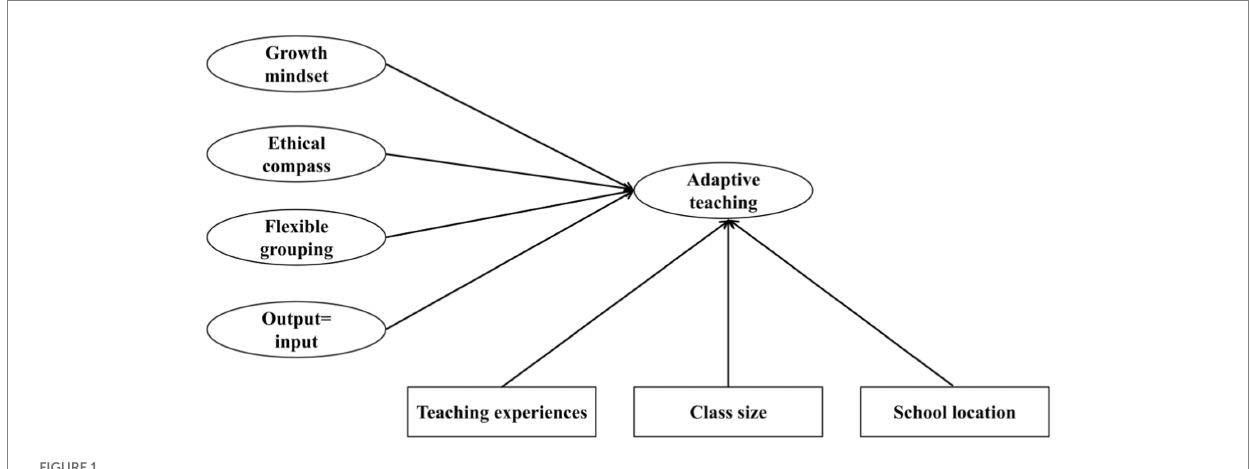
FIGURE 1 The conceptual research model of this